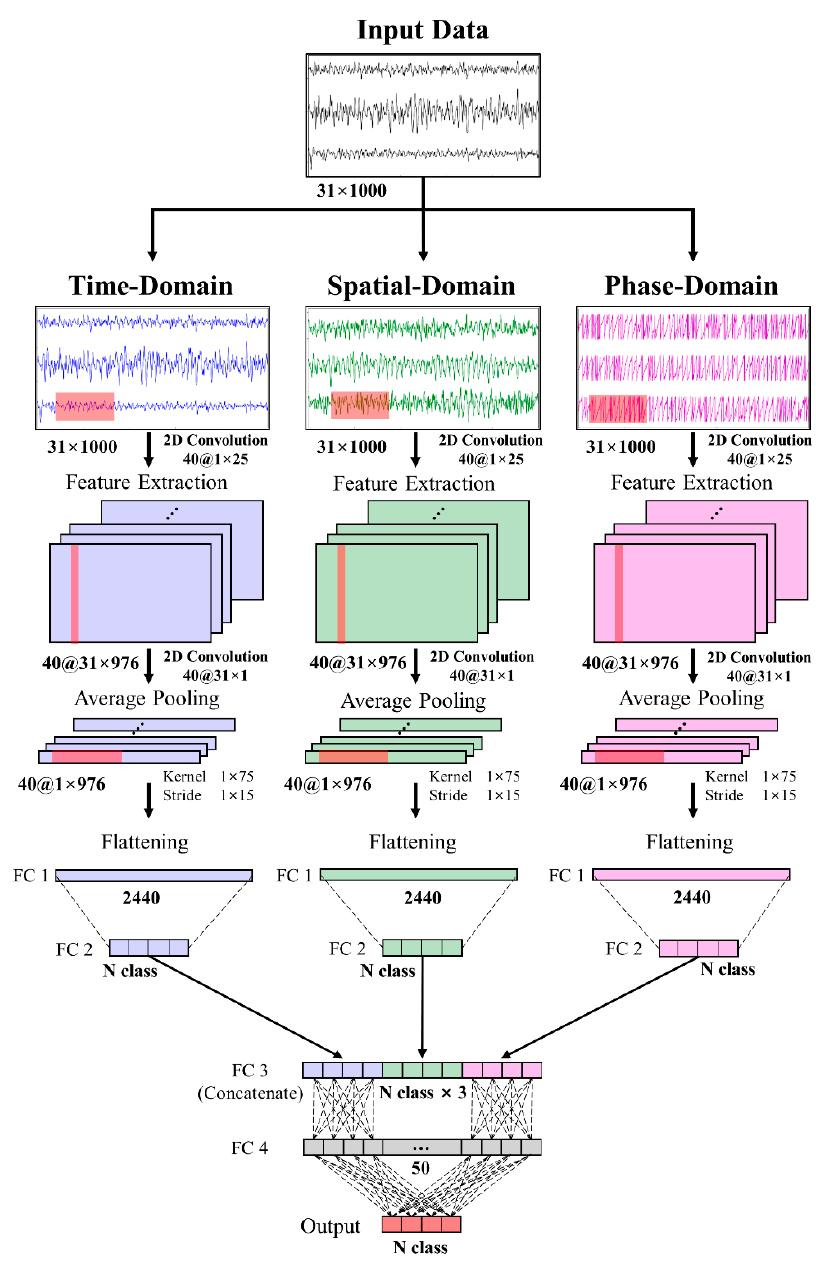
Figure 1. Block diagram of the MD-CNN model’s architecture. Input data are preprocessed into three domains, where each plane represents a feature map, and the features extracted from each multilayer are concatenated.